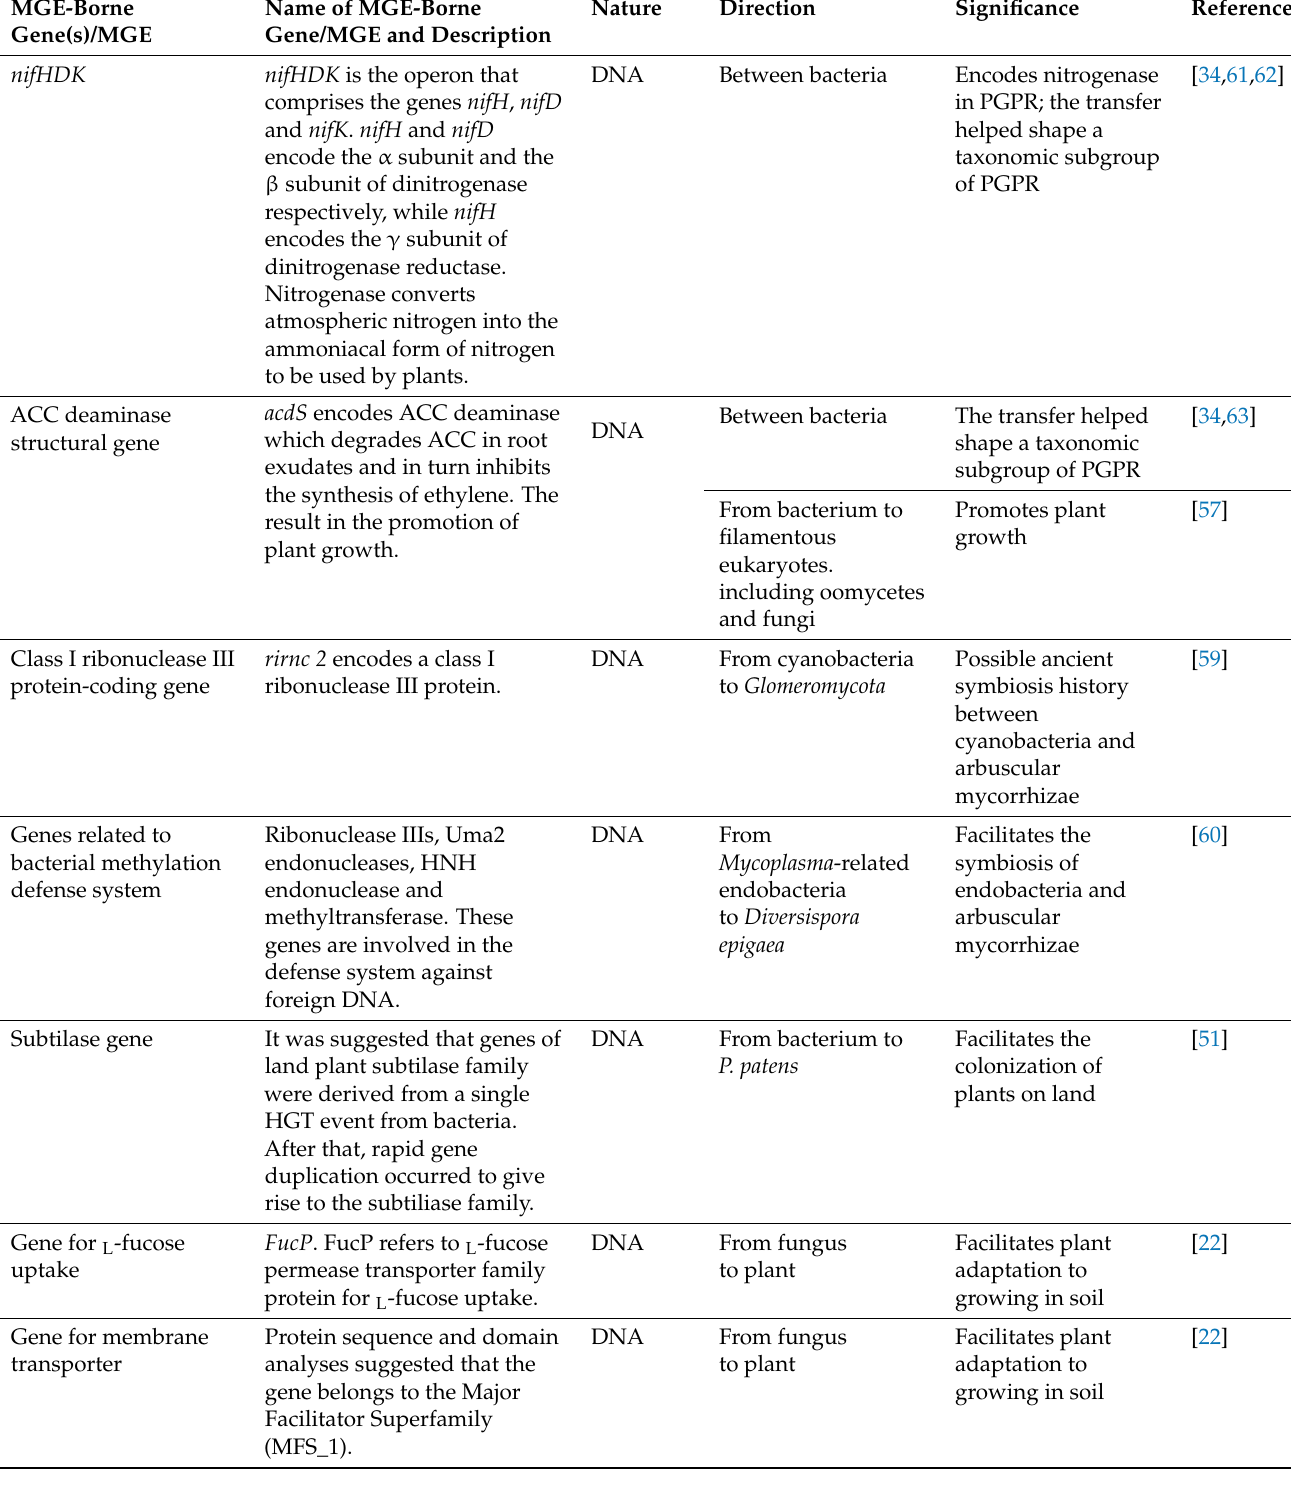
Table 1. Examples of MGE transfers that regulate plant growth or microbe–plant